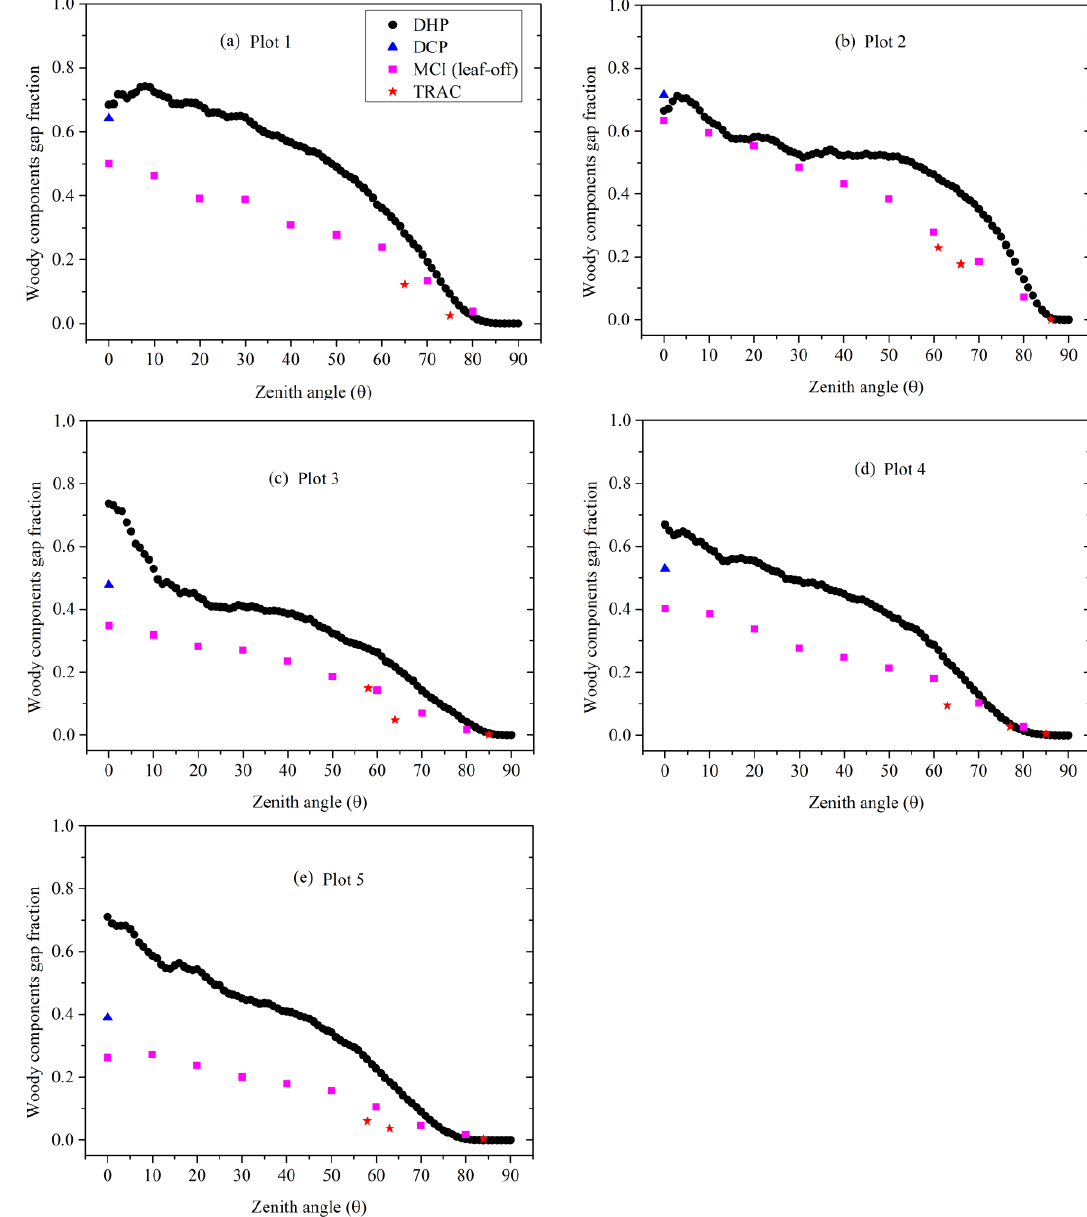
Figure 2. Woody components gap fraction ( p w ( θ ) ) measurements obtained from DHP, TRAC, MCI, and DCP in the five leaf-o ff plots: ( a ) plot 1, ( b ) plot 2, ( c ) plot 3, ( d ) plot 4, and ( e ) plot